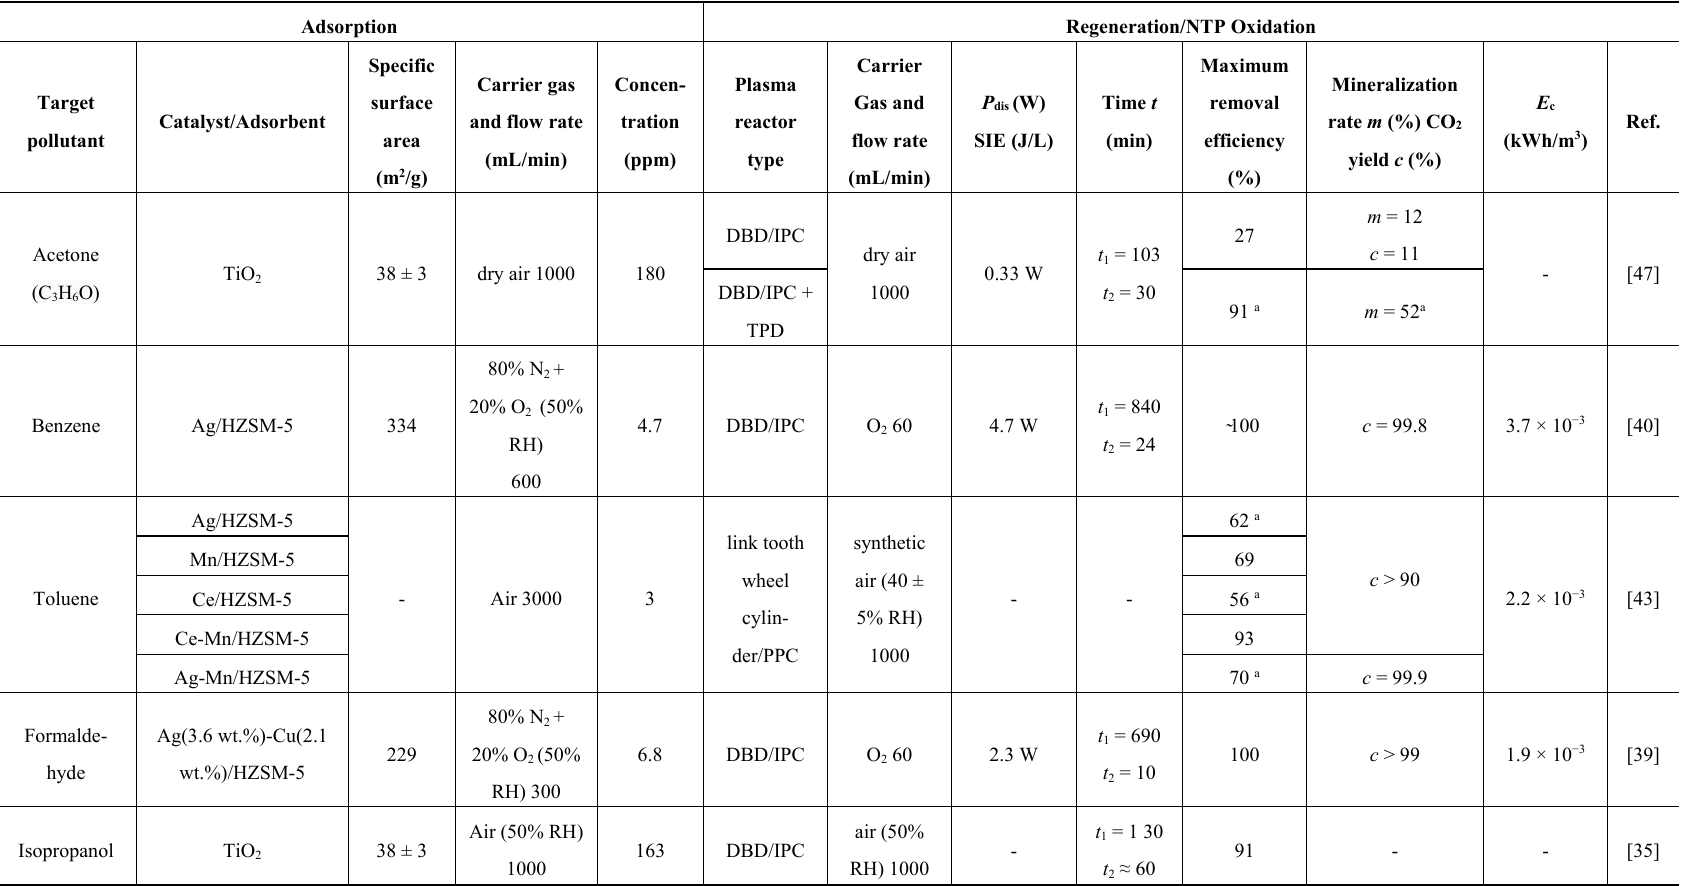
Table 1. Overview of published papers on sequential